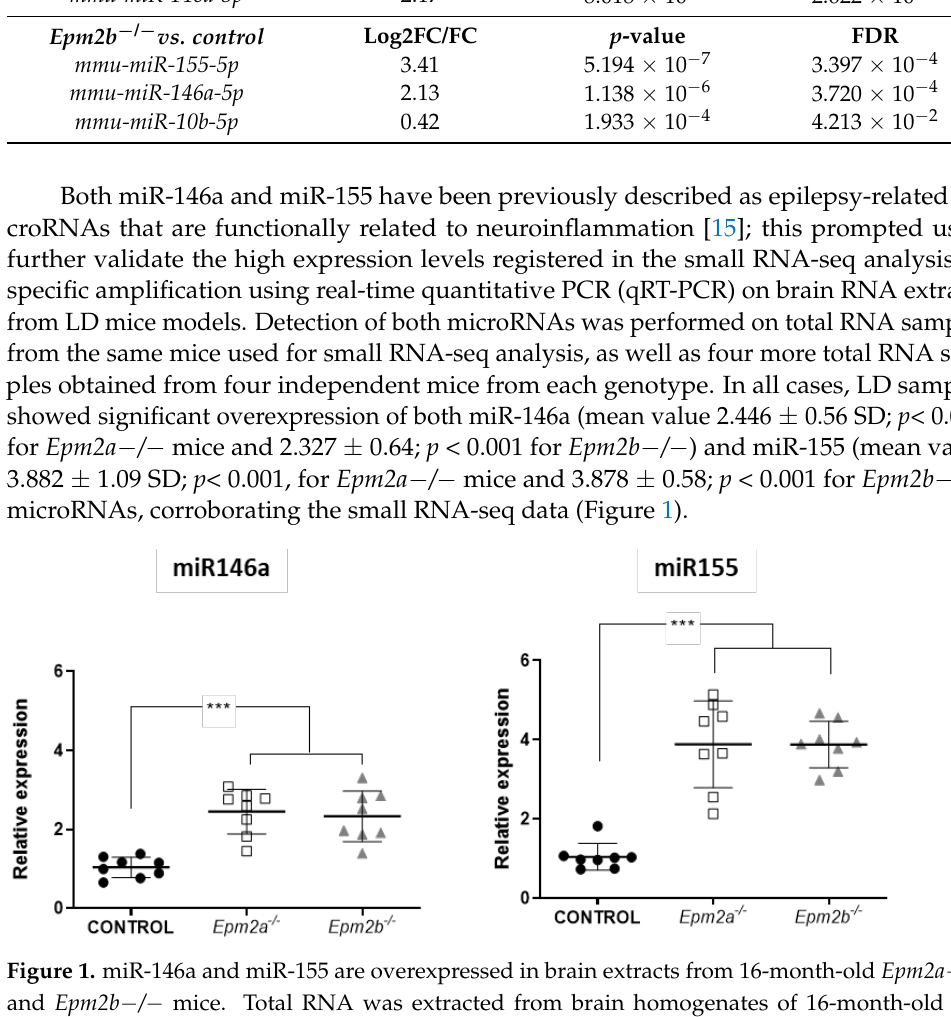
Figure 1. miR-146a and miR-155 are overexpressed in brain extracts from 16-month-old Epm2a −/− and Epm2b −/− mice. Total RNA was extracted from brain homogenates of 16-month-old WT (CON- TROL) and LD KO mice ( Epm2a −/− , Epm2b −/− ), and quantitative real-time PCR analyses were per- formed using the TaqM an™ probe system. The relative expression of both microRNAs was deter- mined using the comparative 2 −ΔΔCT method with the RNU6 gene as an internal reference. *** P < 0.001 when compared to control mice via two-way ANOVA ( n =